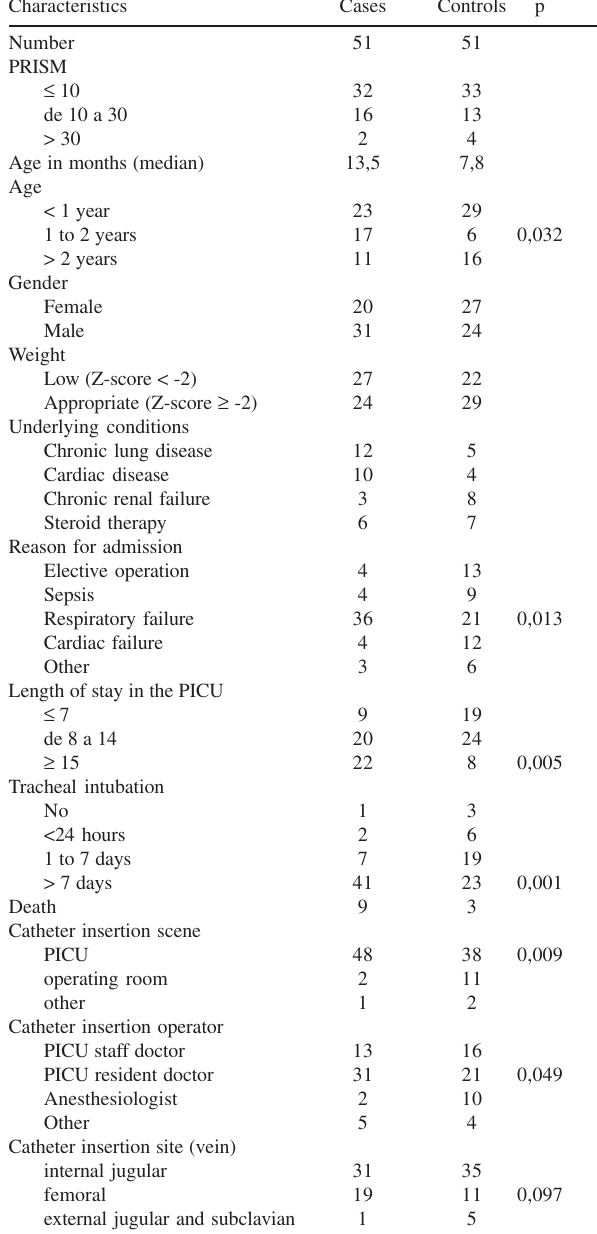
Table 1- Demographic and clinical characteristics.